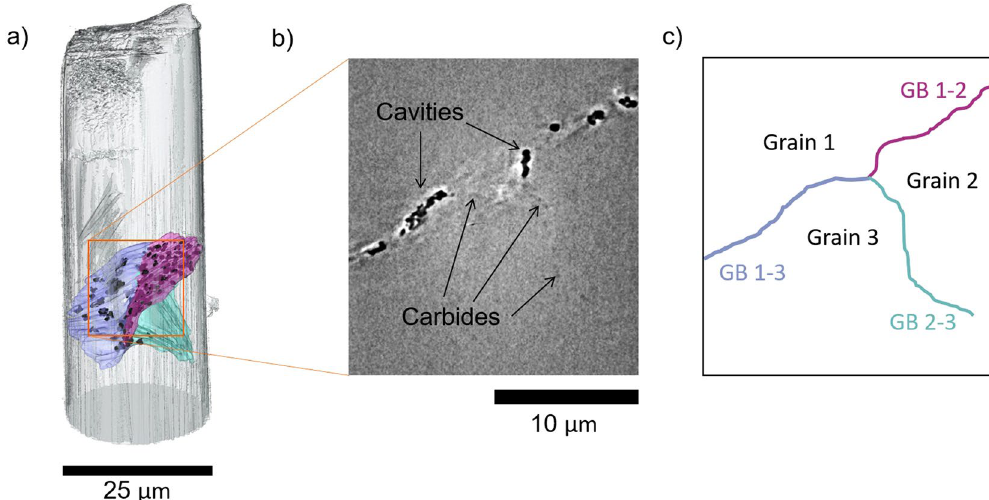
Figure 2. X-ray nanotomography of the micropillar of the ex-service Type 316 stainless steel containing a cavitated grain boundary. ( a ) Volume visualisation displaying an isosurface rendering of the outer surface of the pillar, with traces along the three grain boundaries (coloured blue (grain boundary 1–3), magenta (grain boundary 1–2), and turquoise (grain boundary 2–3)) and the surface of the segmented cavities (black). ( b ) Slice through the X-ray nanotomography reconstruction displaying the three grain boundaries and the intensity changes associated with cavities and intergranular carbides. ( c ) Schematic of the grain boundaries in a 2D slice based on the intensities observed in ( b